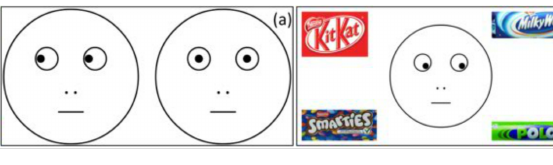
Figure 10: Example questions from Charlie